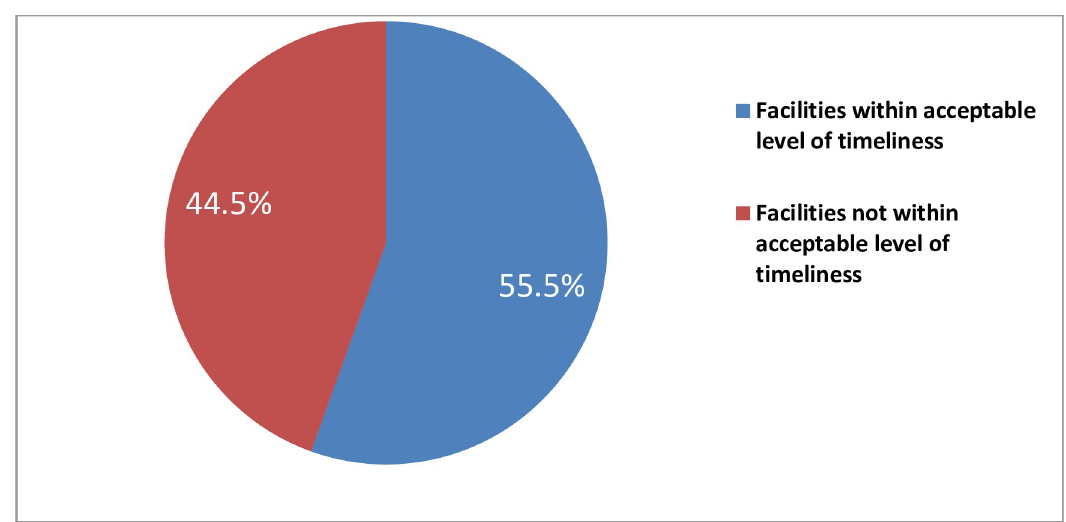
Fig 1. Timeliness of reports in health centers of Hadiya zone, Southern Ethiopia 2018 Supporting